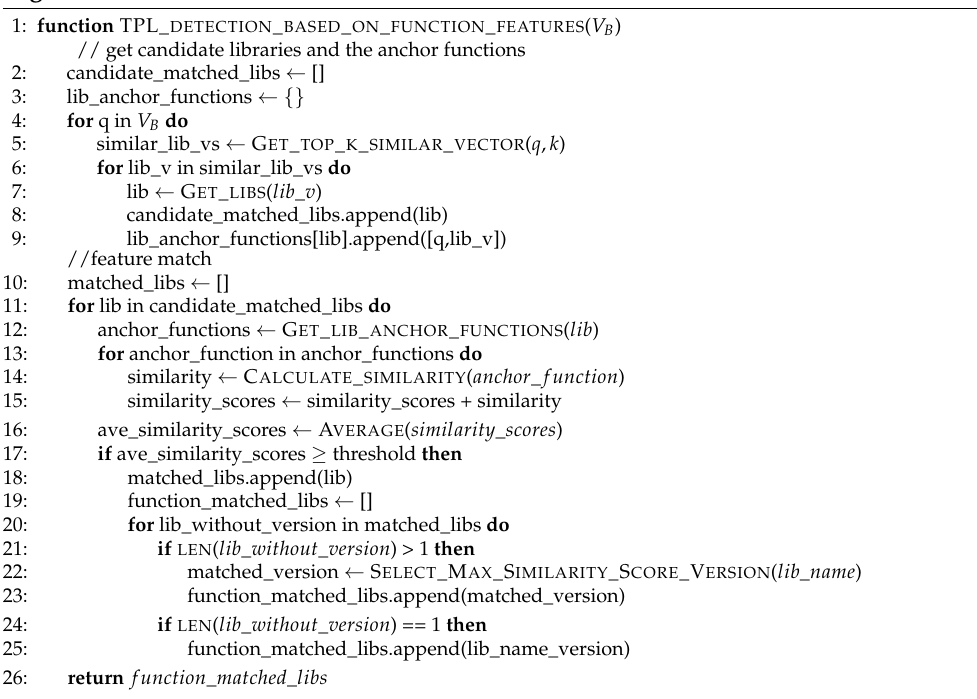
Algorithm 2 TPL detection based on function